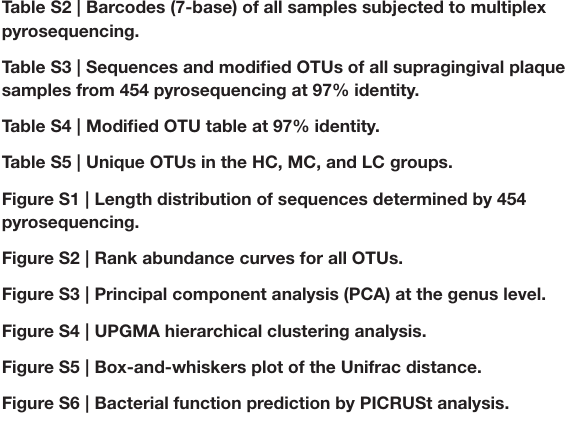
Figure S1 | Length distribution of sequences determined by 454 pyrosequencing. Figure S2 | Rank abundance curves for all OTUs. Figure S3 | Principal component analysis (PCA) at the genus level. Figure S4 | UPGMA hierarchical clustering analysis. Figure S5 | Box-and-whiskers plot of the Unifrac distance. Figure S6 | Bacterial function prediction by PICRUSt